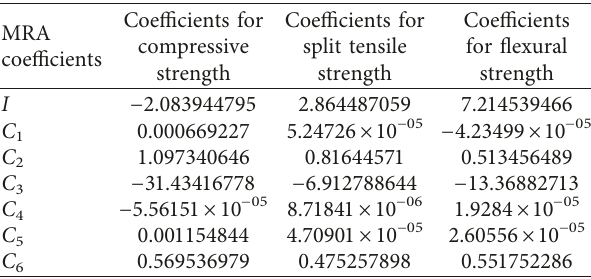
Table 2: Multiple regression analysis coefficients. MRA